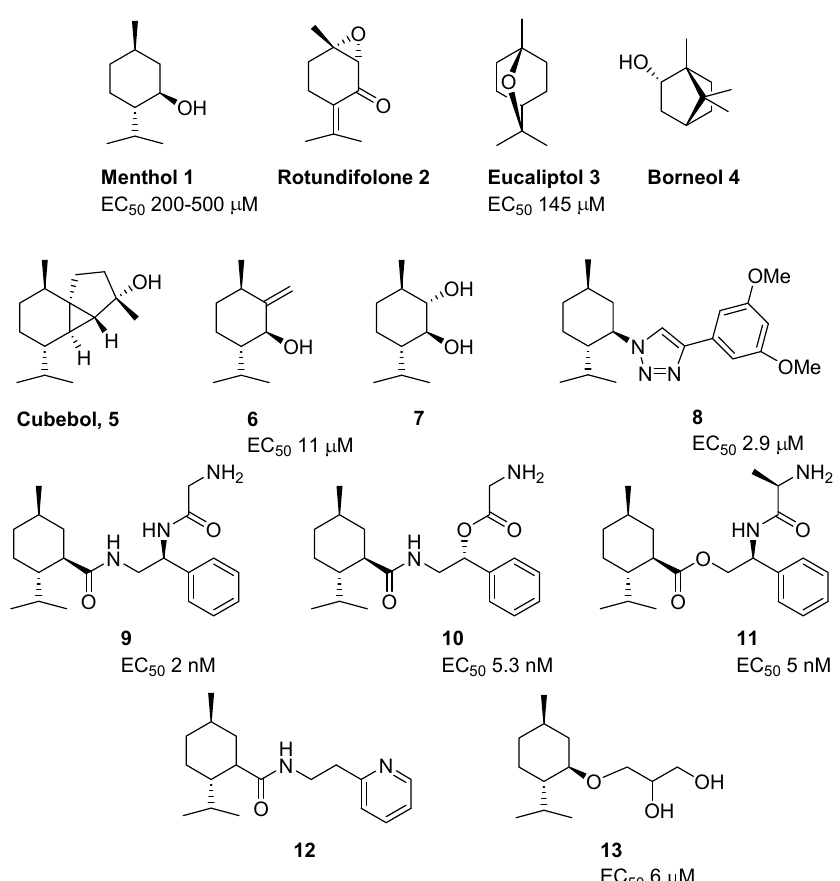
Figure 1. Natural products and recently described menthol-derived TRPM8 agonists.